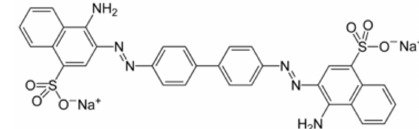
Figure 1. The molecular structure of Congo red